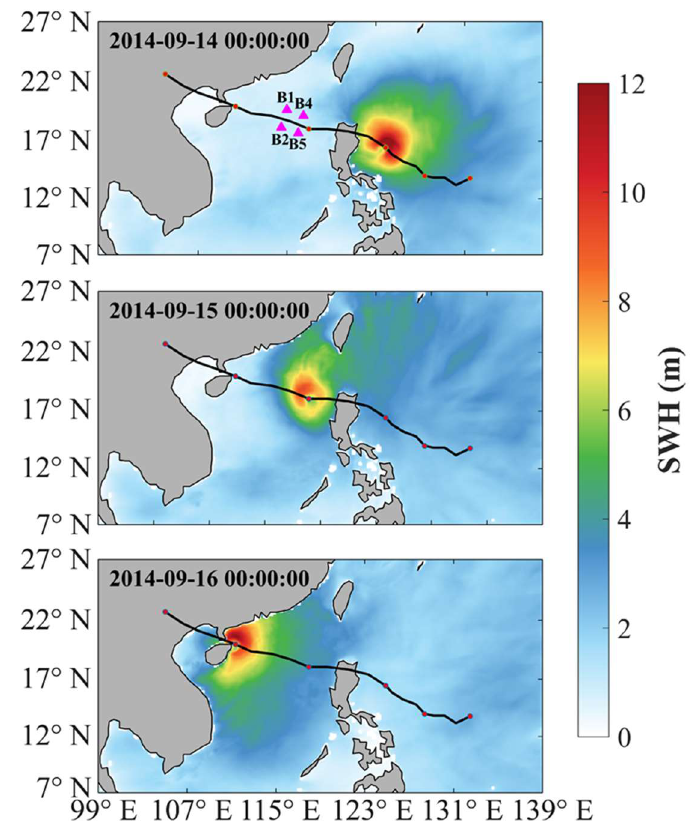
Figure 16. Spatial distribution of significant wave height (m; background color) from the WRS coupled experiment. Top to bottom: 00:00 14 September, 00:00 15 September and 00:00 16 September. The black line shows the TC track and the red dots are the TC positions between 12 to 17 September, with 1-day intervals, and the magenta triangles are the positions of the buoys.